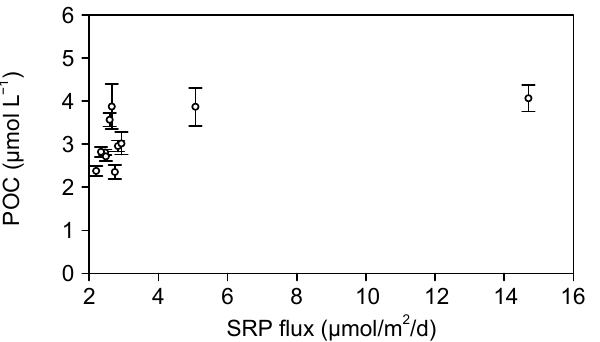
Fig. A5. POC as a function of vertical flux of SRP across the BV47 transect (see Fig. 1). Points represent means ± SE. POC was significantly correlated with SRP flux (Spearman rank correlation, ρ =0.63,